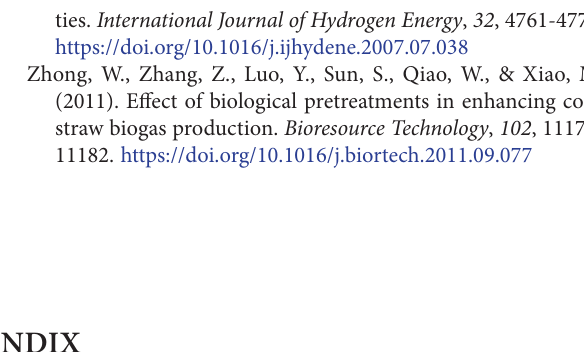
Table 1S. Statistical comparison of hydrogen production from batch test with no pretreatment (ANOVA, p value, Tukey ’ s test)